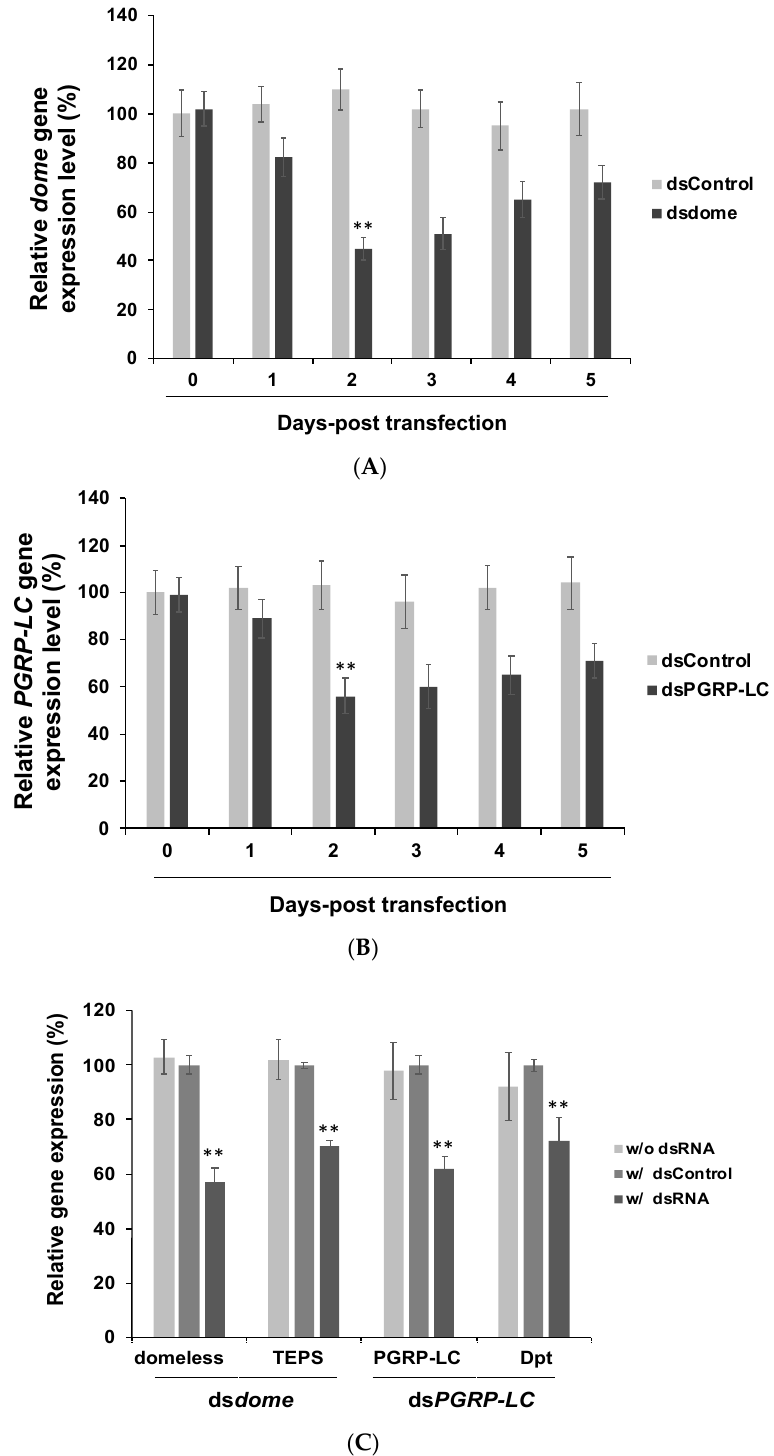
Figure 1. The expression of domeless and PGRP-LC decreased after being knocked down by dsRNA.